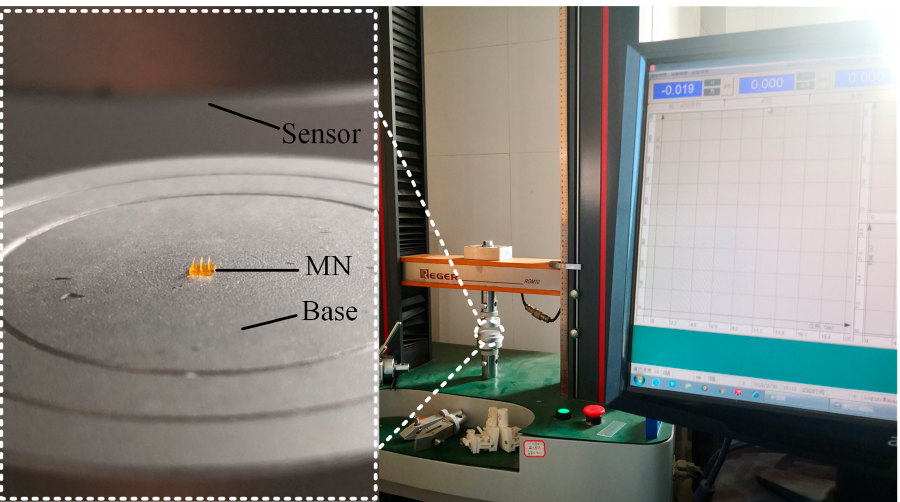
Figure 1. Simplified schematic of high-precision digital light processing (H-P DLP) system.